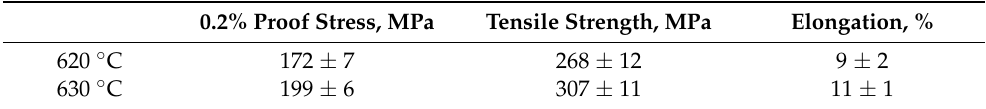
Table 4. Tensile strength, elongation and 0.2% proof stress of tensile samples in the cup-shaped part via semi-solid compression.